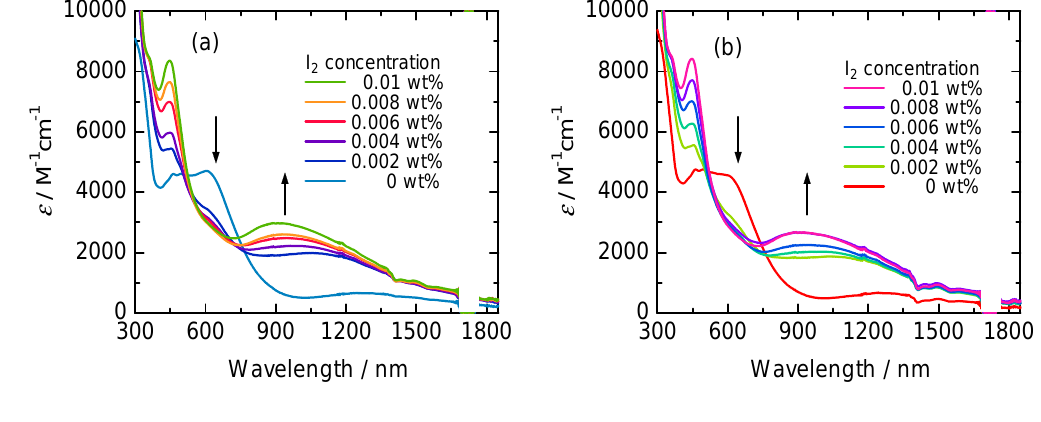
Figure 4. UV-Vis-NIR absorption spectra of (–)-poly1 ( a ) and (+)-poly2 ( b ) in THF solution with iodine